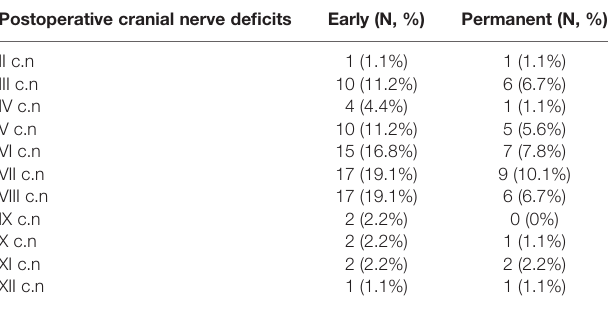
TABLE 4 | Postoperative cranial nerve de fi cits of patients who underwent surgery. Postoperative cranial nerve de fi